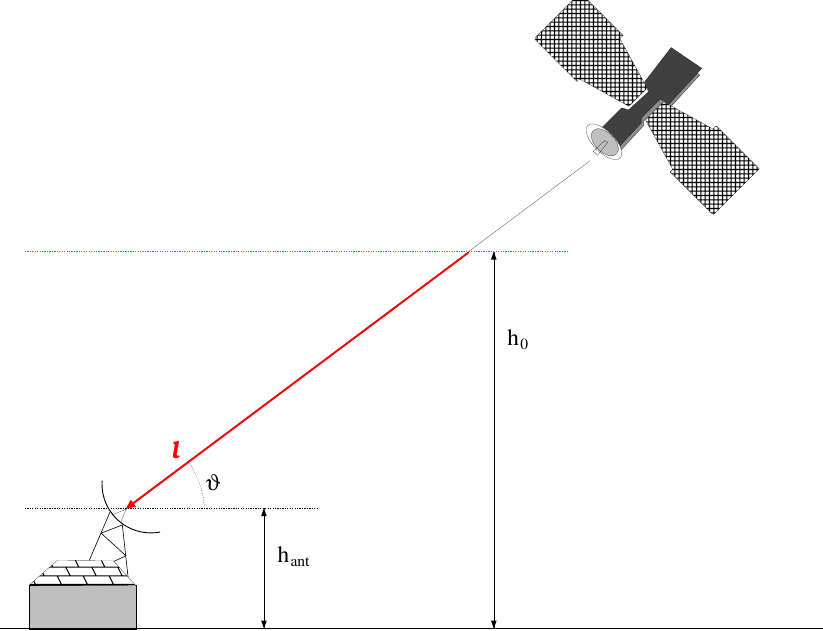
Figure 1. Measurement segment for the rain estimation by evaluation of the DVB-S/S2 signal’s